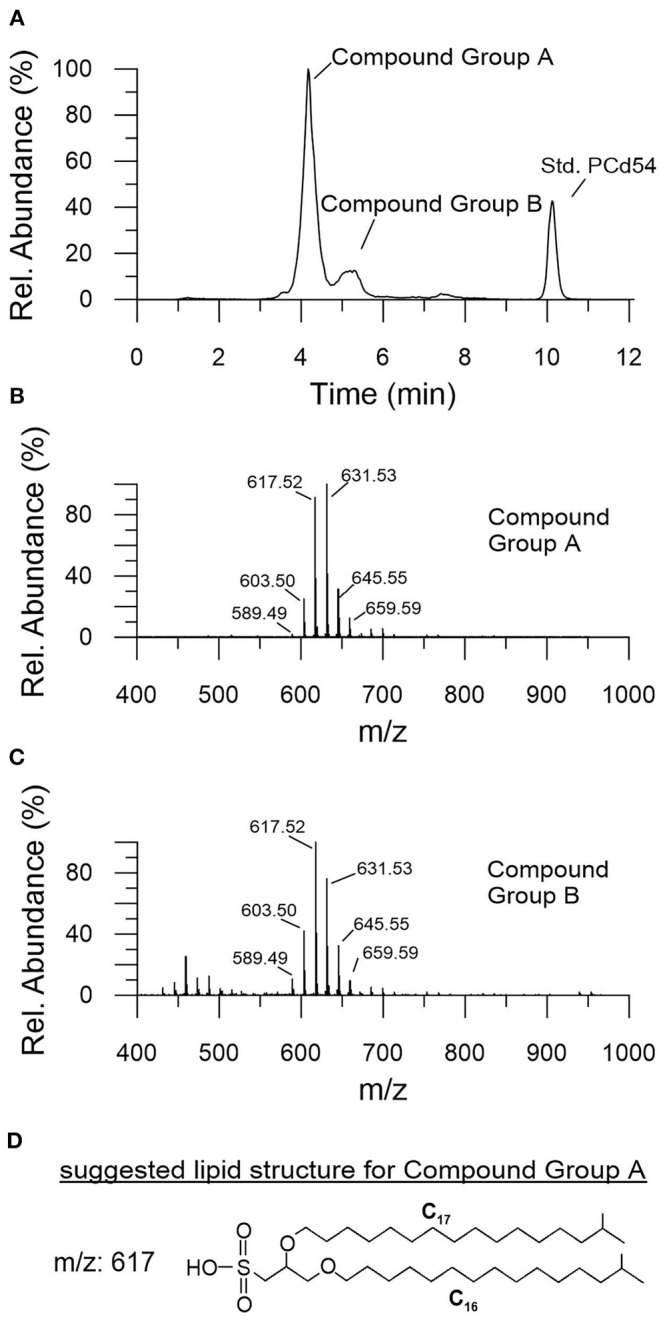
Description of the yet unknown groups of intact polar lipids (IPLs) referred to as compound group A and B. (A) HPLC chromatogram, (B,C) associated mass spectra, both showing a cluster of six individual mass peaks differing by 14 mass units with a maximum at m/z 631 or 617, respectively. (D) Suggested lipid structure for the mass peak at m/z 617 of compound A.